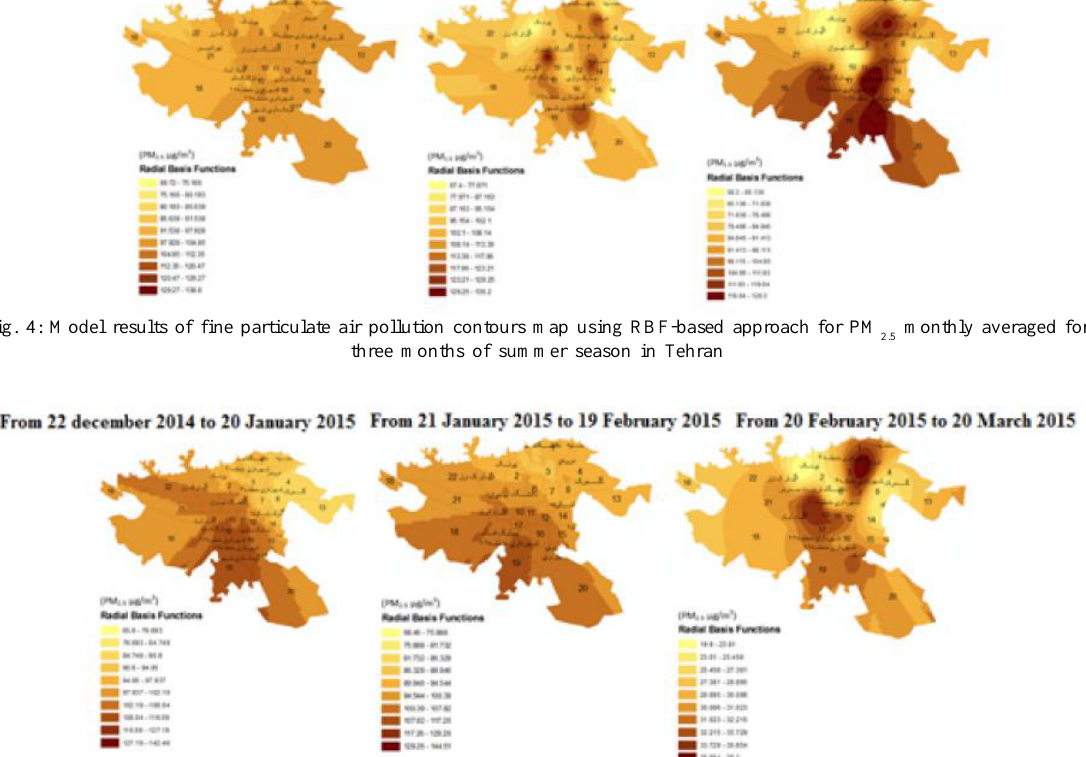
monthly averaged for 2.5